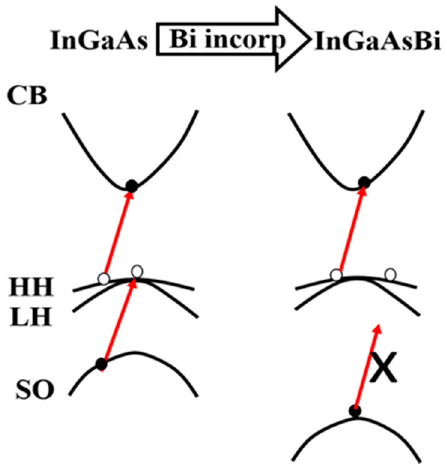
Figure 15. Sketch of Bi-related changes in the band structure of InGaAsBi alloys.